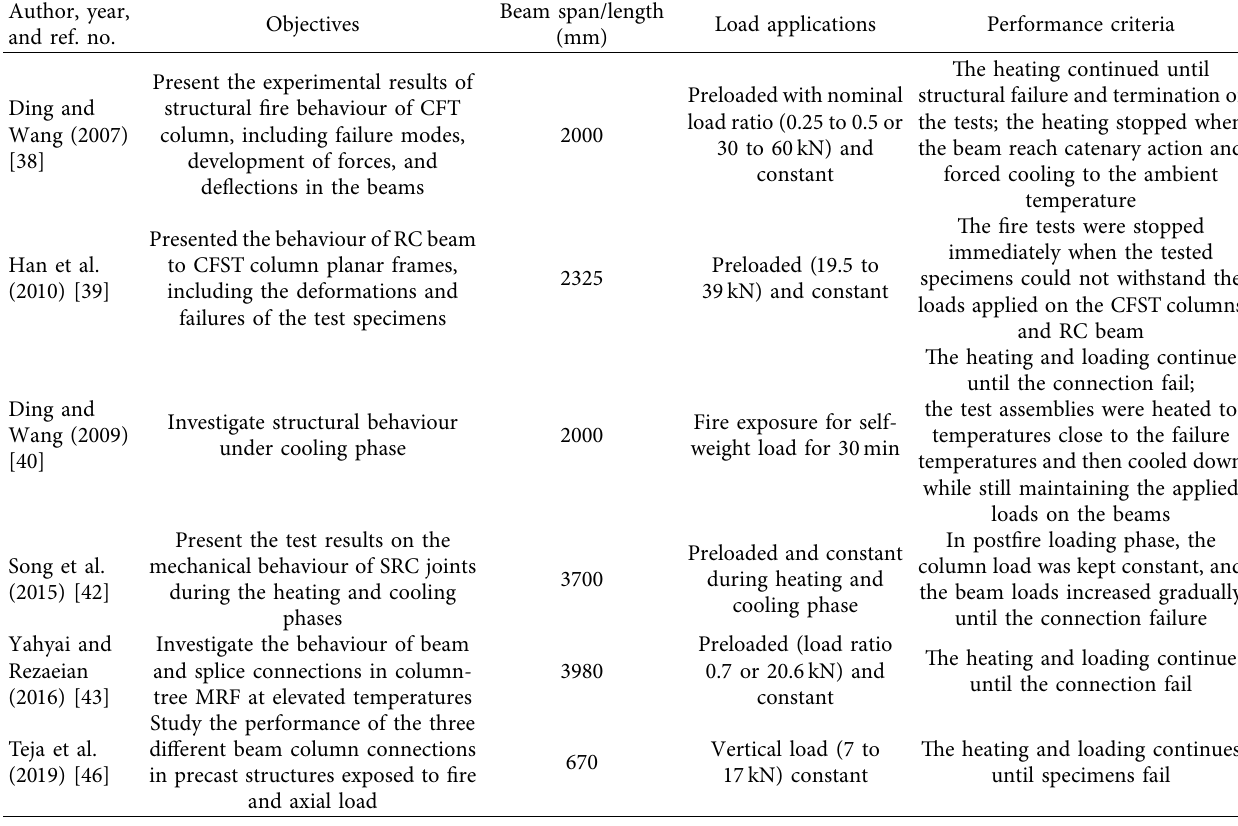
Table 3: Studies that terminated the fire tests when the specimens